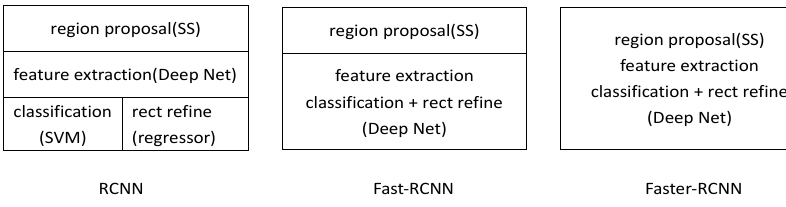
Figure 8. Relationship among R-CNN, fast R-CNN, and faster R-CNN.